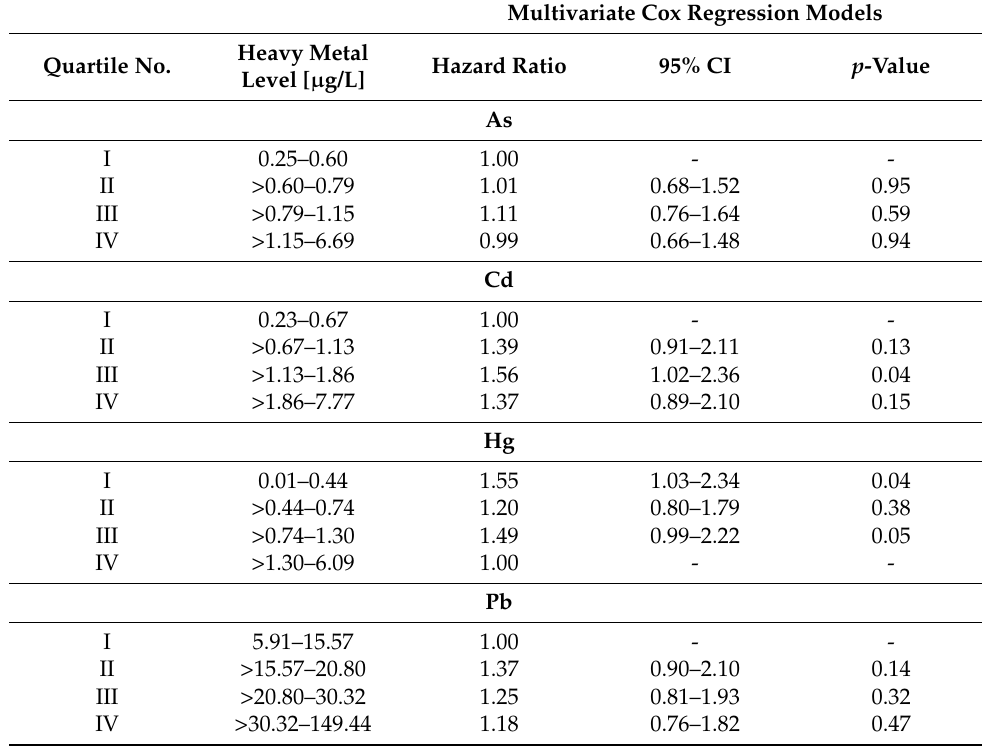
Table 2. Hazard ratios and 95% confidence intervals for various factors on survival from lung cancer depending on As, Cd, Hg and Pb levels.